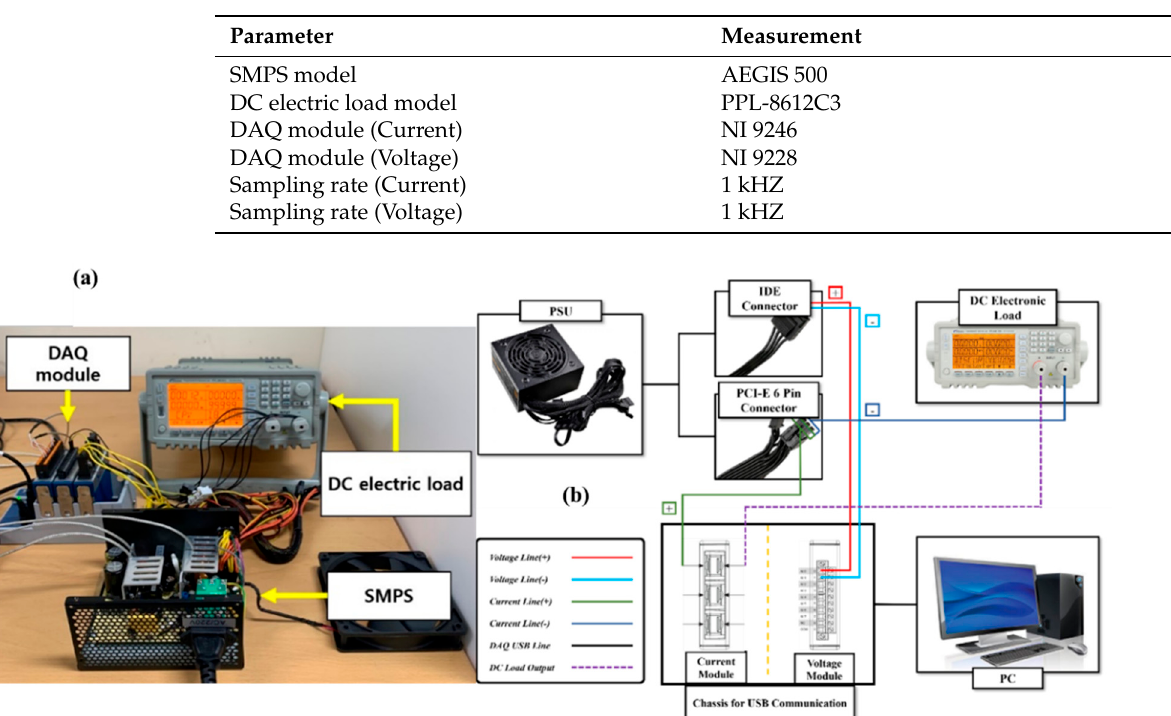
Table 3. Parameters for SMPS RUL Test.